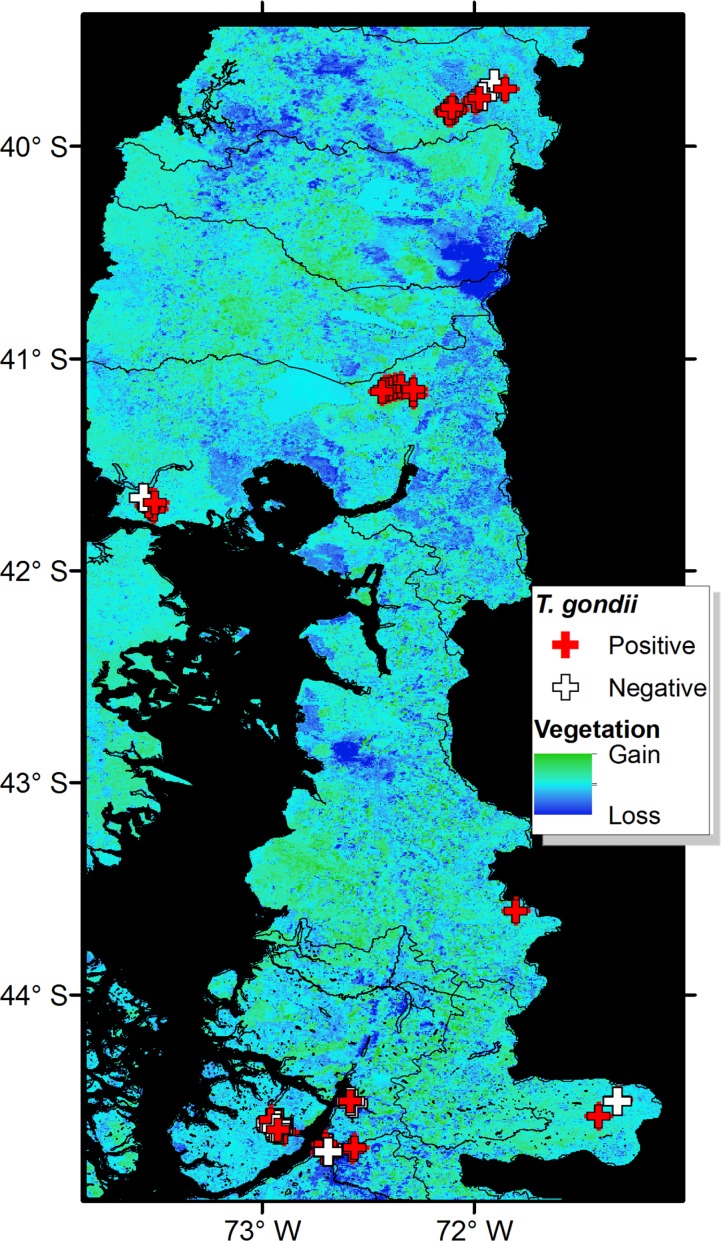
Land cover change and Toxoplasma gondii reports.Positive (red crosses) and negative (white crosses) reports of T. gondii in wildlife compared with vegetation change represented in the second principal component of the EVI 2002 and 2012. Change was denoted as areas of vegetation gain (green) and stability (light blue), and considerable vegetation loss (dark blue).